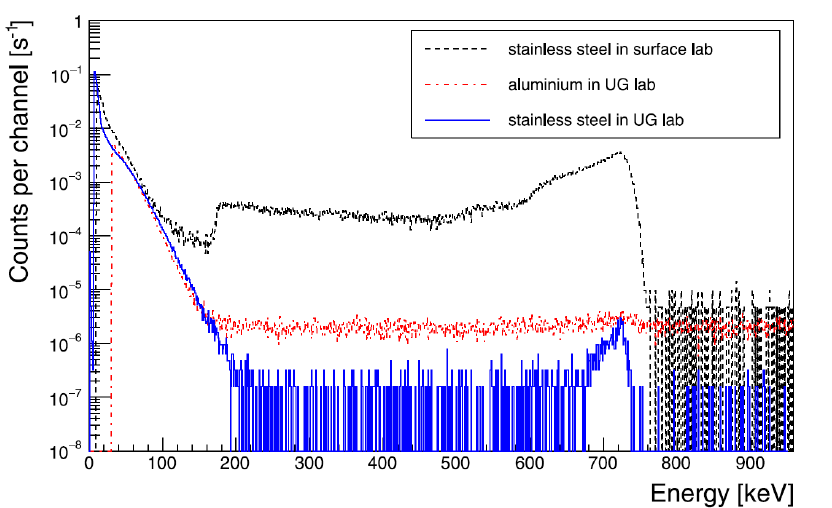
Figure 2. The spectra, as presented in [12], for surface measurements with stainless steel He3 pro- portional counters (black dots) and underground measurements with both aluminum (red dots) and stainless-steel (blue line) He3 proportional counters. See also [13] for more